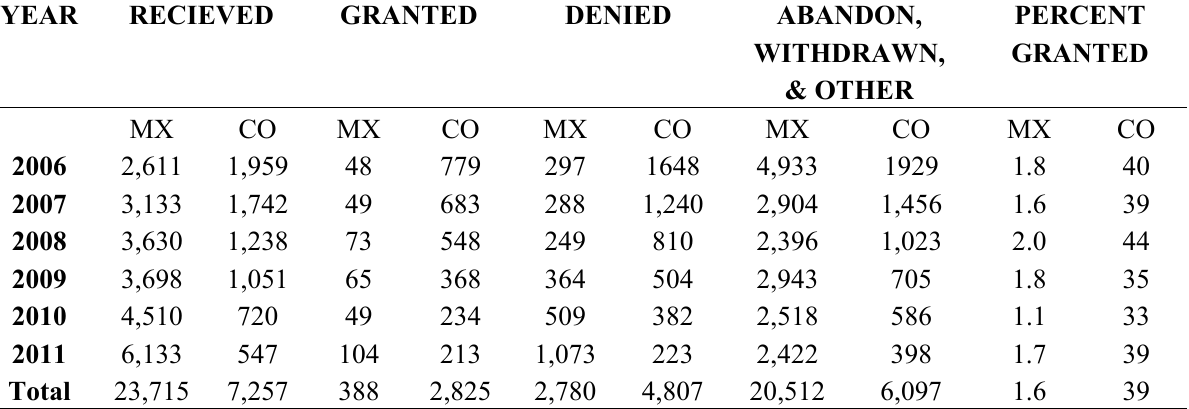
Table 1 . México and Colombia Asylum Statistics from U.S. Immigration Courts,